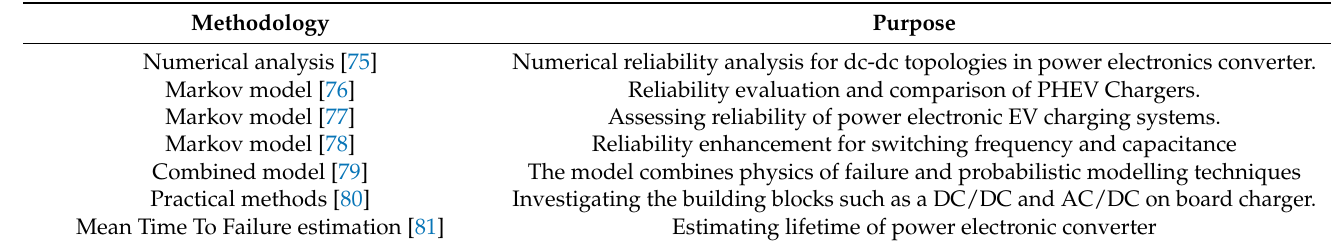
Table 4. State-of-the-art reliability assessment methods for EVs.